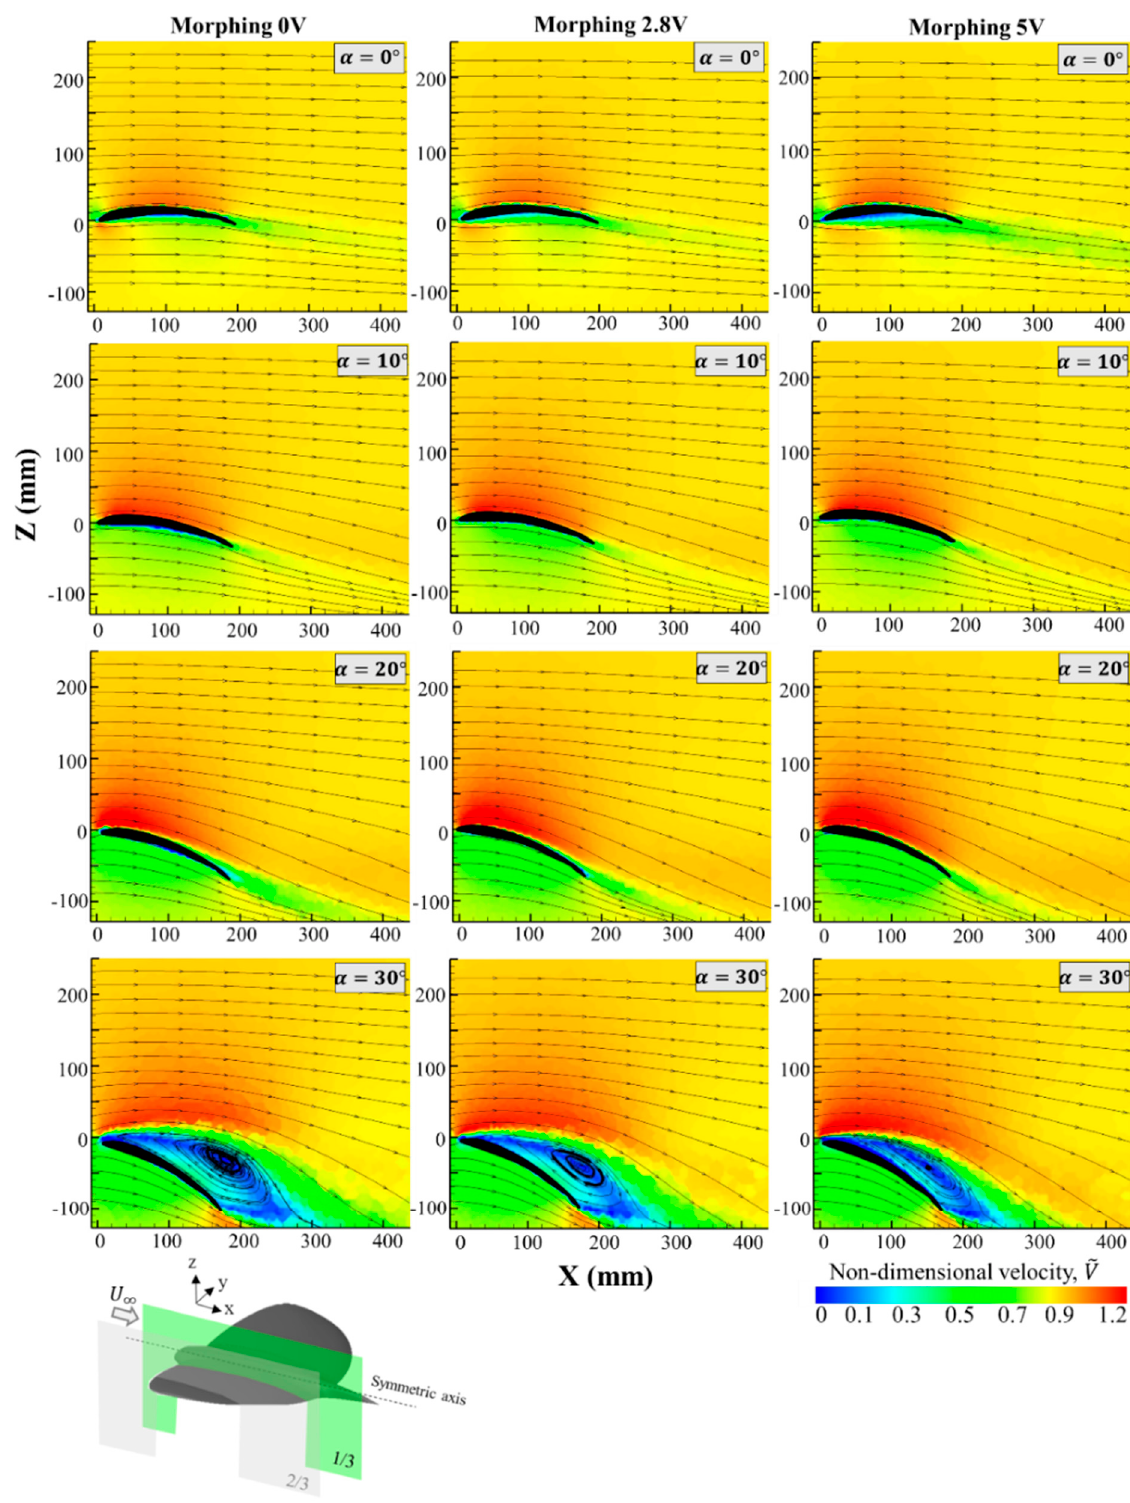
Figure 7. Non-dimensional velocity maps at 1/3 (cid:101) b for all wing configurations: morphing 0 V, 2.8 V and 5 V ( U ∞ = 10 m/s, β = 0 ◦ ).